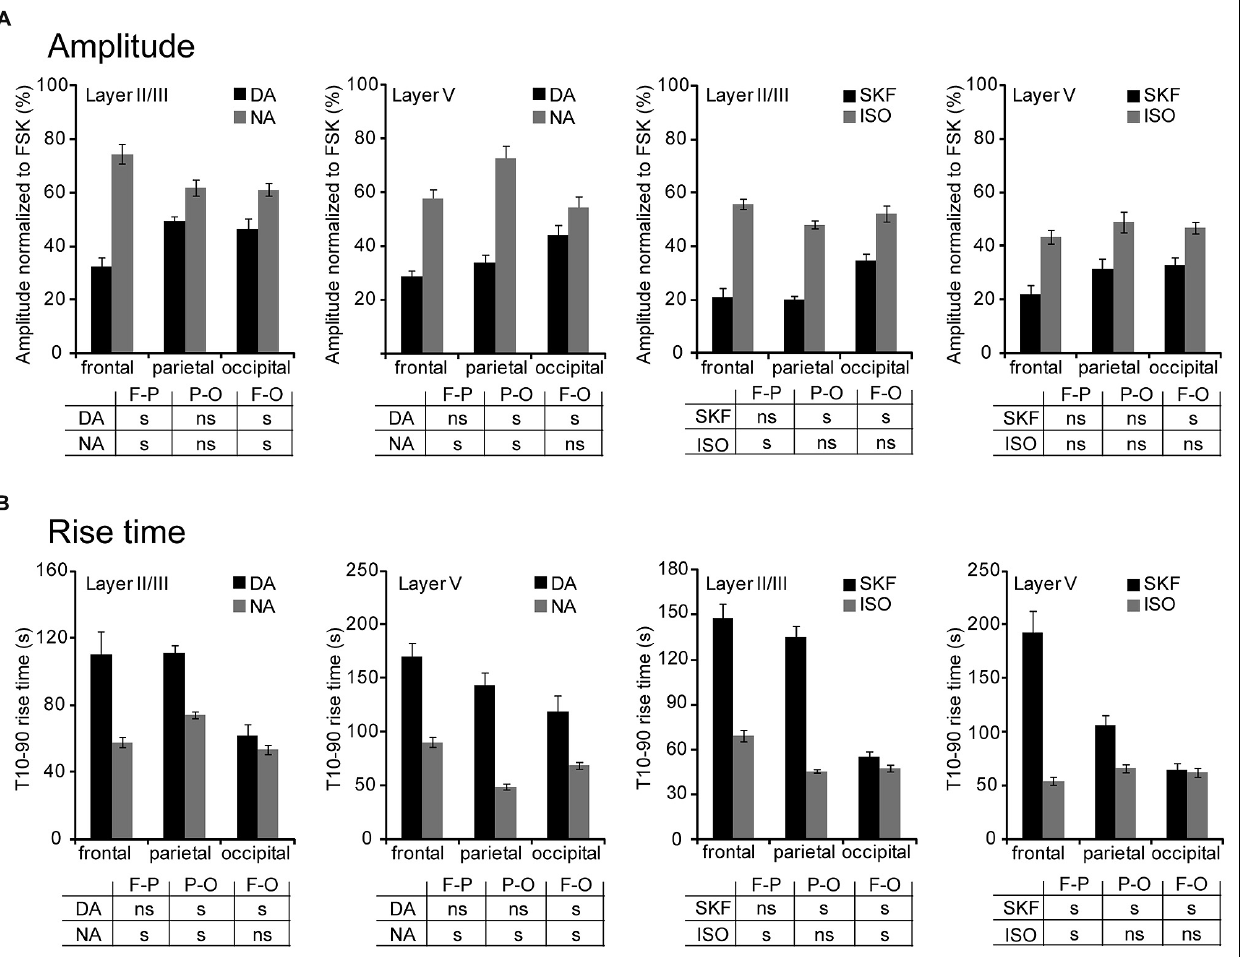
FIGURE 4 | NA and DA activate PKA across cortical regions and layers. Data were obtained by 2-photon imaging of PKA activity in pyramidal neurons as illustrated in Figure 3 . Imaging was performed in frontal, parietal, and occipital regions of parasagittal slices of the medio-lateral cortex that exhibits scarce DA fibers restricted to deep layers. (A) Amplitude of fluorescence